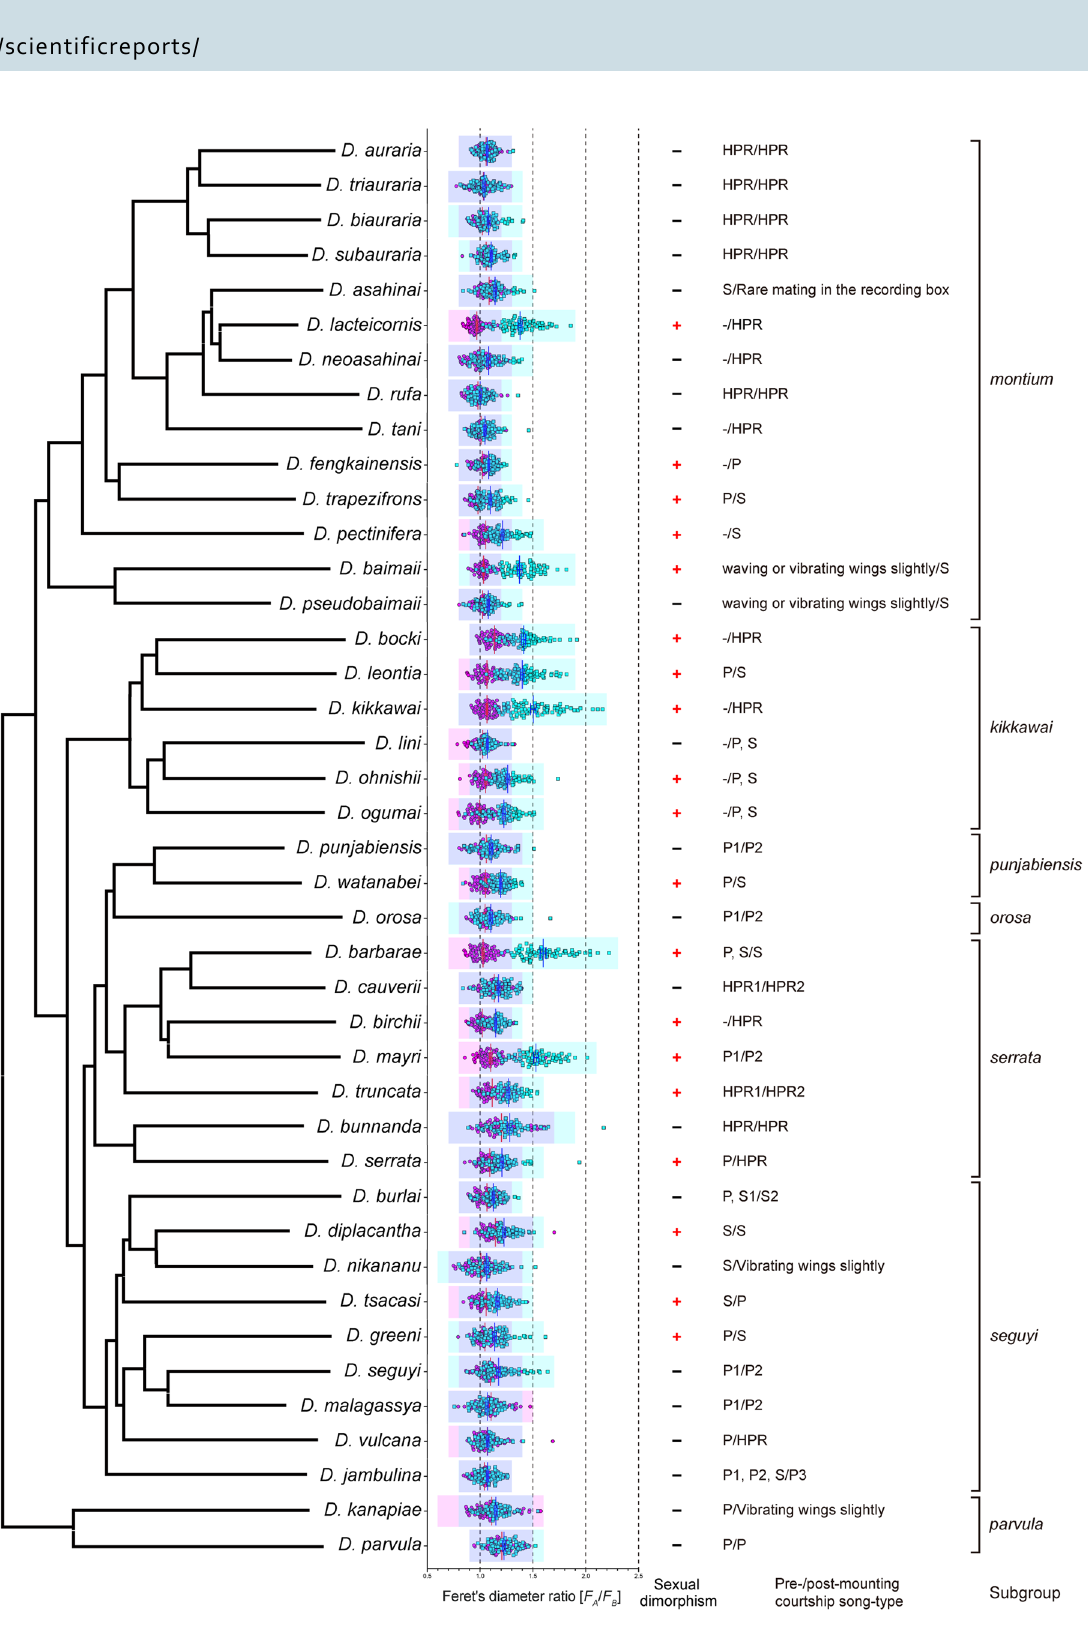
Figure 3. Divergent neuromuscular sexual dimorphisms in A5 among species of the montium group. F A /F B values in the 41 species examined are shown on the phylogenetic tree. The scatter plot shows the distribution of mean F A /F B values as compared between the male and female. Each symbol represents the values estimated for a hemi-segment. The red and blue long lines represent the mean values for female and male values, respectively. The short bar represents the SEM. The blue and pink areas in the graph indicate the 99% confidence intervals (mean ± 3 × SD values) of the muscle size for males and females, respectively. The neuromuscular system in the A5 segment is sexually dimorphic (+) or sexually monomorphic (−). Courtship song-types reported in our previous paper (Chen et al. 8 ) are indicated in the right-hand side of the plots. The song types for pre ‐ and post ‐ mounting songs are shown separated by a hyphen (pre/post): P1–P3, pulse songs (P) distinct in certain song parameters; HPR, high pulse repetition song; S1 and S2, sine songs (S) distinct in certain song parameters; –, no